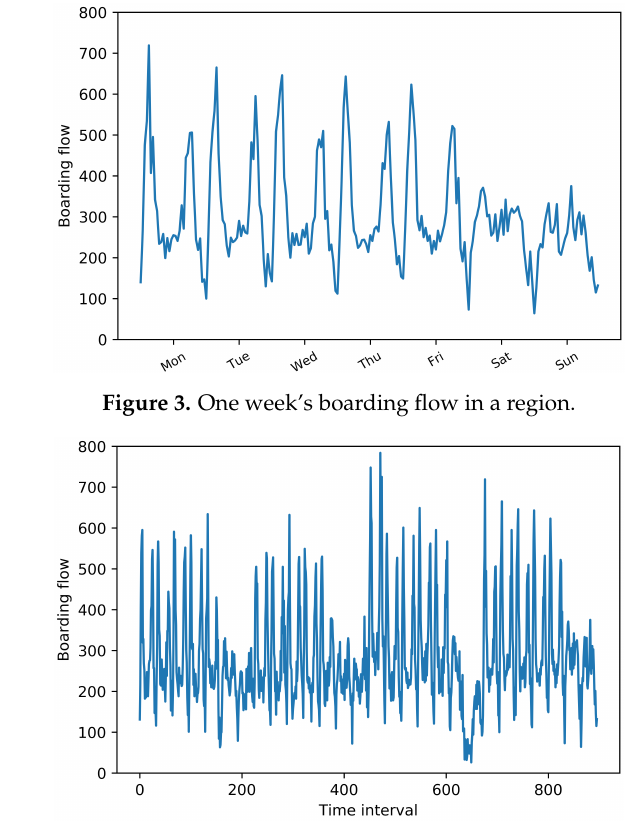
Figure 4. Boarding flow of different time intervals in a region. The time interval is 30 min, starting from 6:00 on 3 August